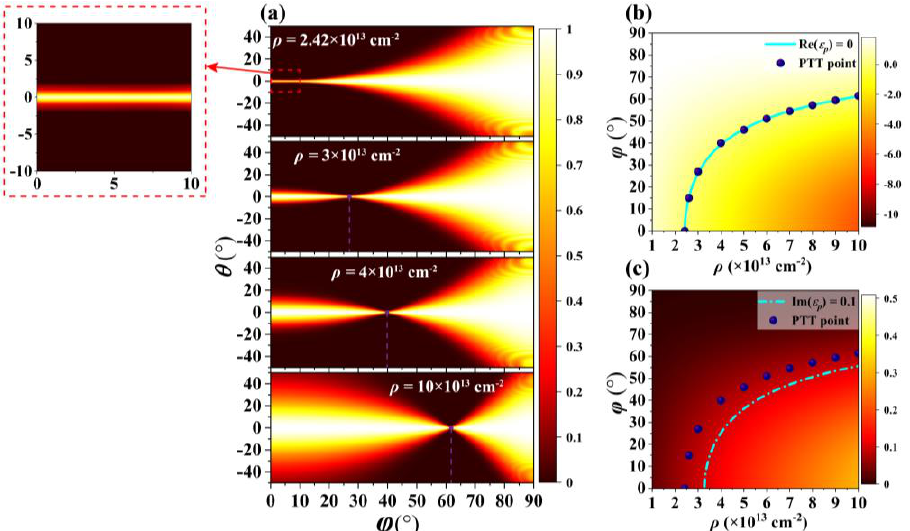
simulation calculation. The cyan solid line in the Figure 5b represents Re ( ε p ) = 0, and the cyan dashed line in the Figure 5c represents Im ( ε p ) = 0.1. It is found that these purple dots obtained by Figure 4. ( a ) Numerically simulated optical transmission as a function of the angle ϕ and incident angle Figure 4. (a) Numerically simulated optical transmission as a function of the angle φ and incident θ when ρ = 2.42 × 10 13 , 3 × 10 13 , 4 × 10 13 , and 10 × 10 13 cm − 2 , respectively. ( b ) Re( ε angle θ when ρ = 2.42 × 10 13 , 3 × 10 13 , 4 × 10 13 , and 10 × 10 13 cm −2 , respectively. (b) Re( ε p ) and (c) Im( ε p ) function of ρ and ϕ . as function of ρ and φ .